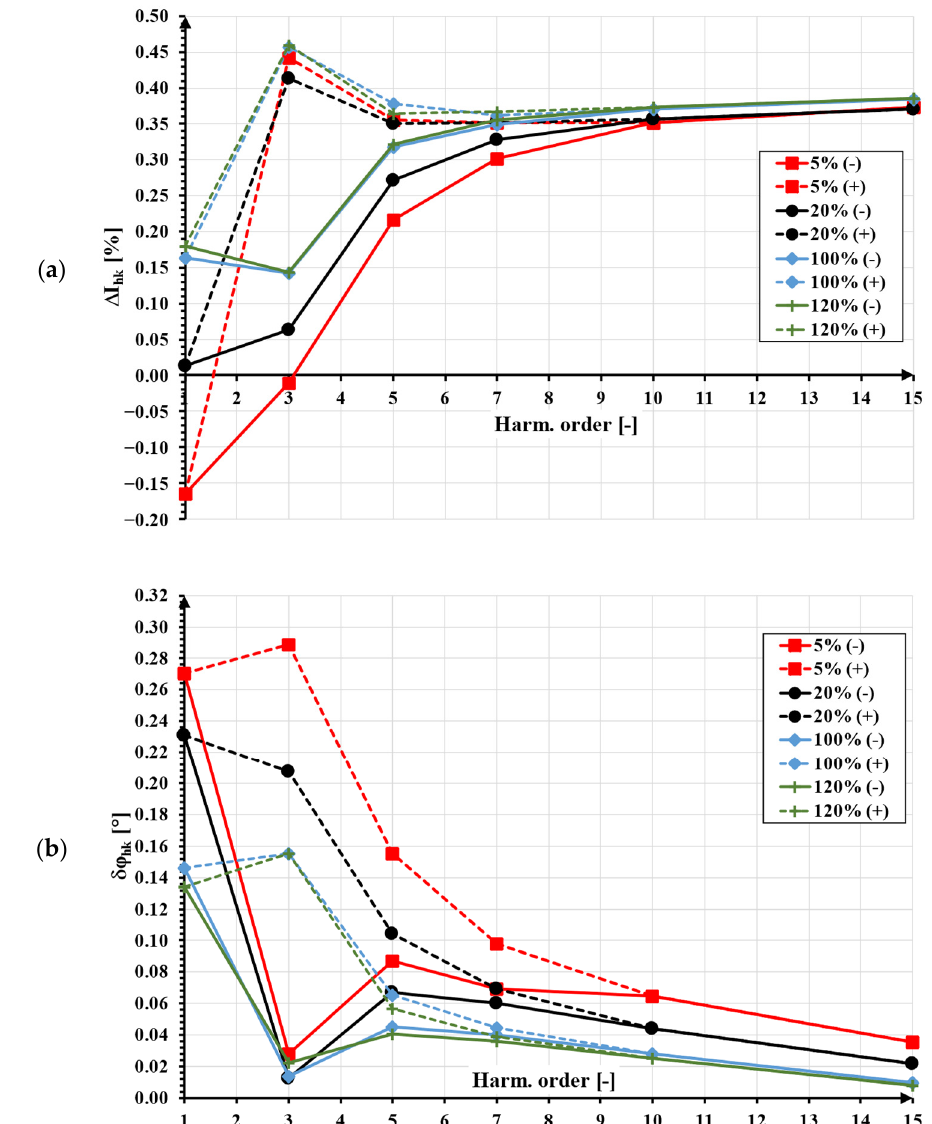
Figure 5. The most positive (+) and most negative ( − ) values of ( a ) current error and ( b ) phase displacement determined for inductive CT 300 A/5 A with 25% of the rated resistive load of the secondary winding [4].